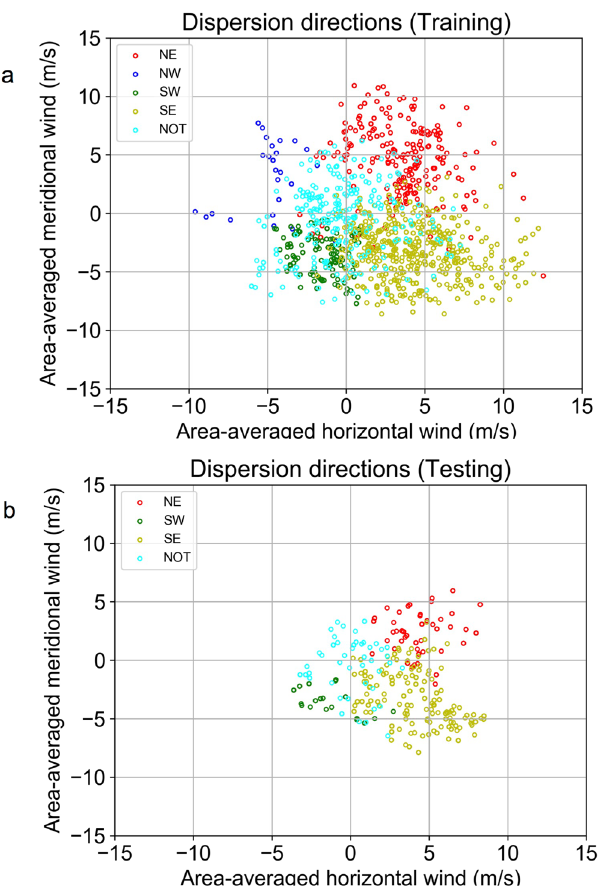
Figure 2. Simulated dispersion directions by area-averaged winds. ( a ) The training data collected in March from 2009 to 2013. ( b ) The testing data collected in March 2011. The colours represent categorized dispersion directions. These graphs were created using Python 3.6.